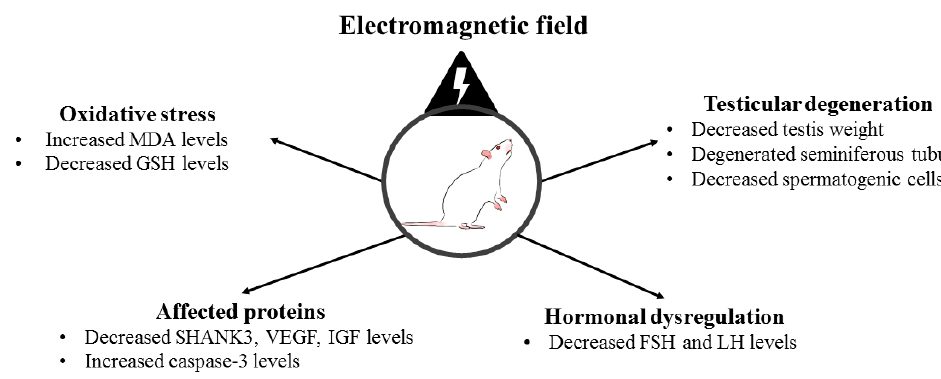
Figure 5. The main findings of the study.